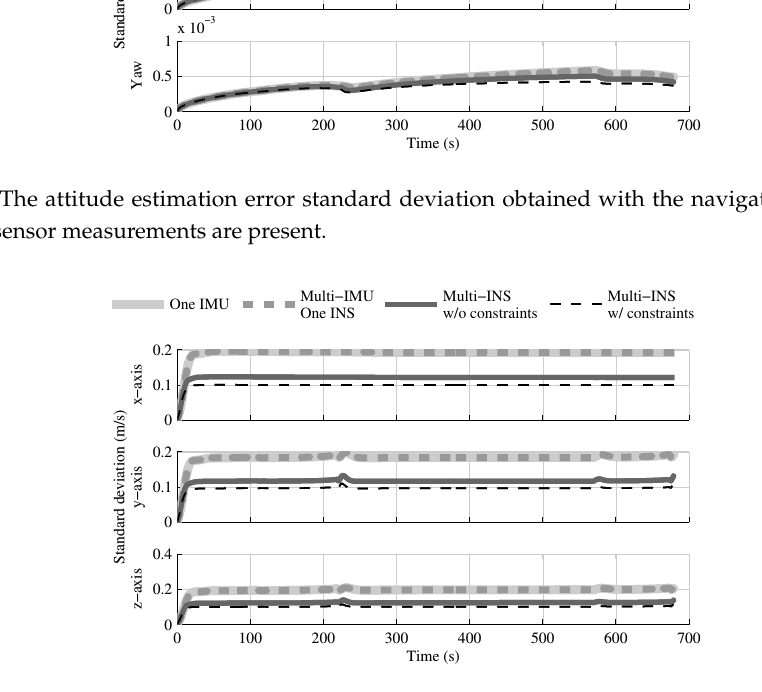
Figure 5. The velocity estimation error standard deviation obtained with the navigation solutions, when all sensor measurements are present.